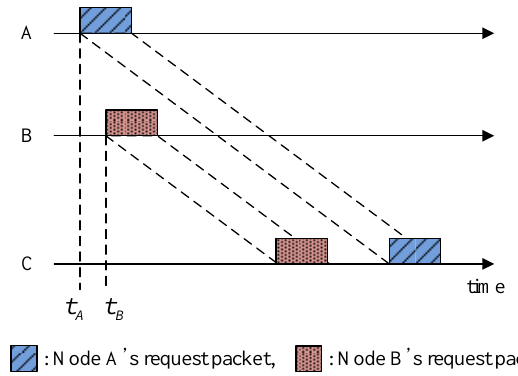
Figure 2. Illustration of the spatial unfairness problem in